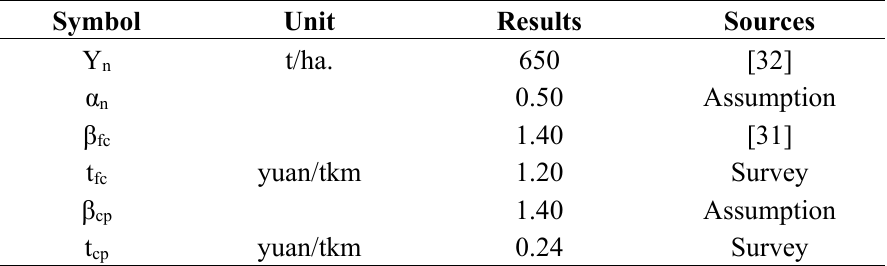
Table 8. Key parameters for feedstock cost